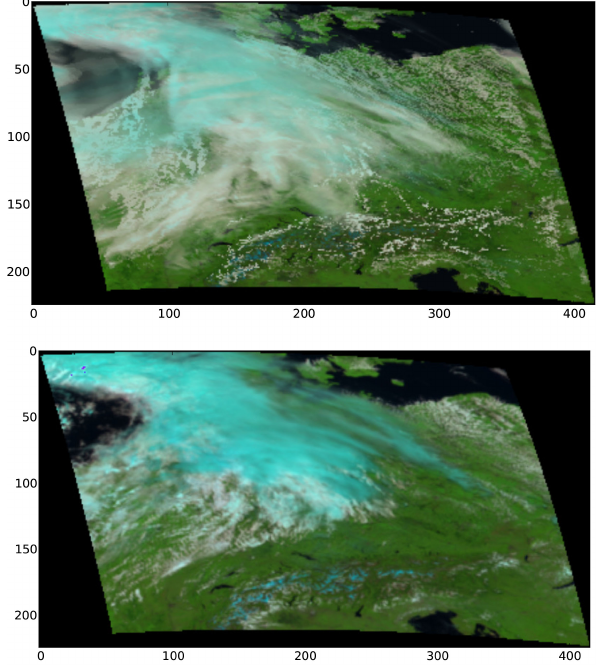
Figure 9. (Top) simulation of MSG-SEVIRI image. False colour composite, where red corresponds to the 1.6µm channel, green to 0.8µm, and blue to 0.6µm. The simulation was performed using the disort solver with input data from the operational COSMO-DE forecast for the 15 July 2012, 12:00UTC. The axes correspond to SEVIRI pixel. (Bottom) corresponding SEVIRI